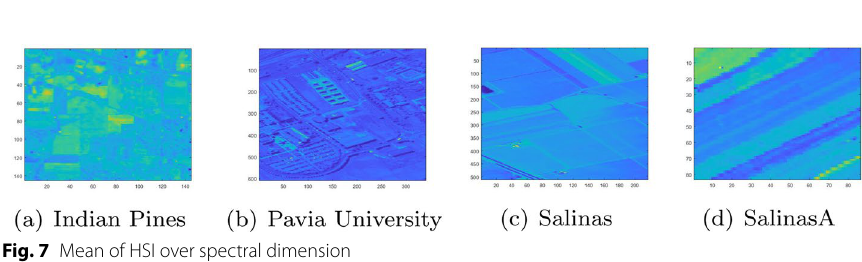
Fig. 7 Mean of HSI over spectral dimension